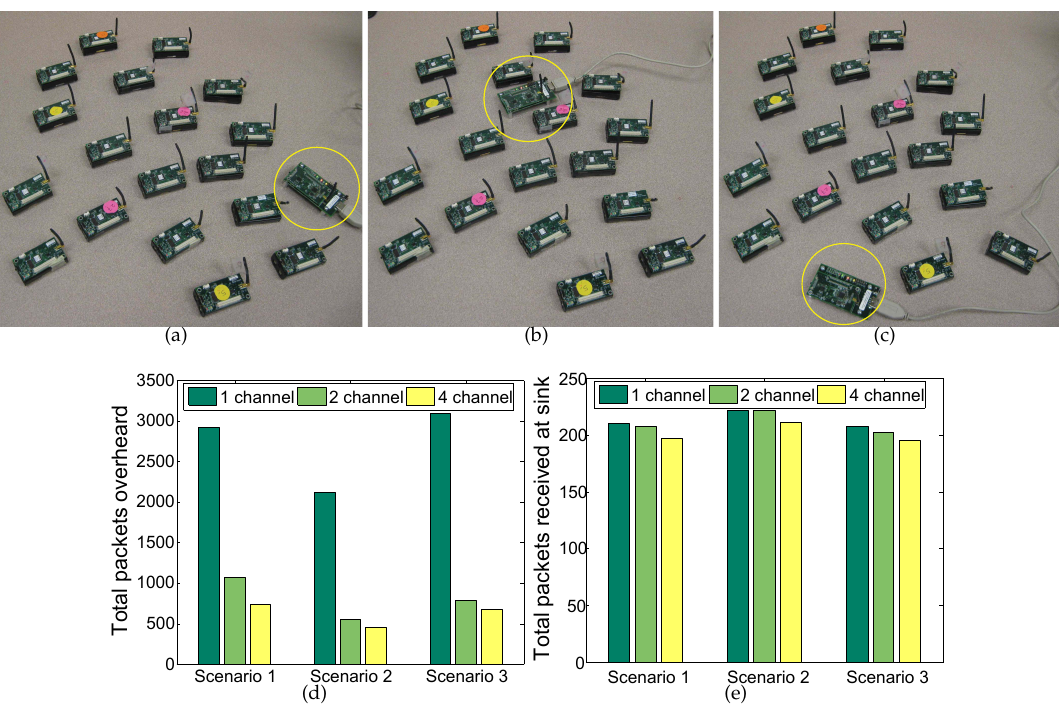
Figure 9. Different deployment scenarios for the experimental testbed and test results. The sink locations are marked by yellow circles: ( a ) Scenario-1; ( b ) Scenario-2; ( c ) Scenario-3; ( d ) results obtained on the total packets overheard; and ( e ) the number of packets delivered to the sink, with 1, 2, and 4